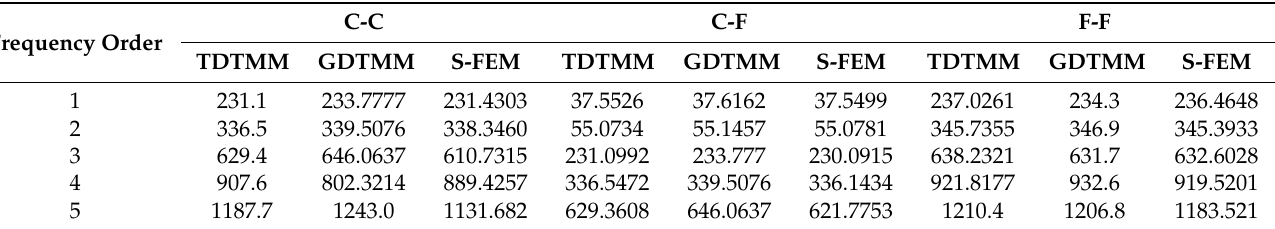
Table 6. Natural frequencies (Hz) for the beam of example 2 with three boundary conditions (C-C, C-F, F-F) obtained by TDTMM, GDTMM and S-FEM.